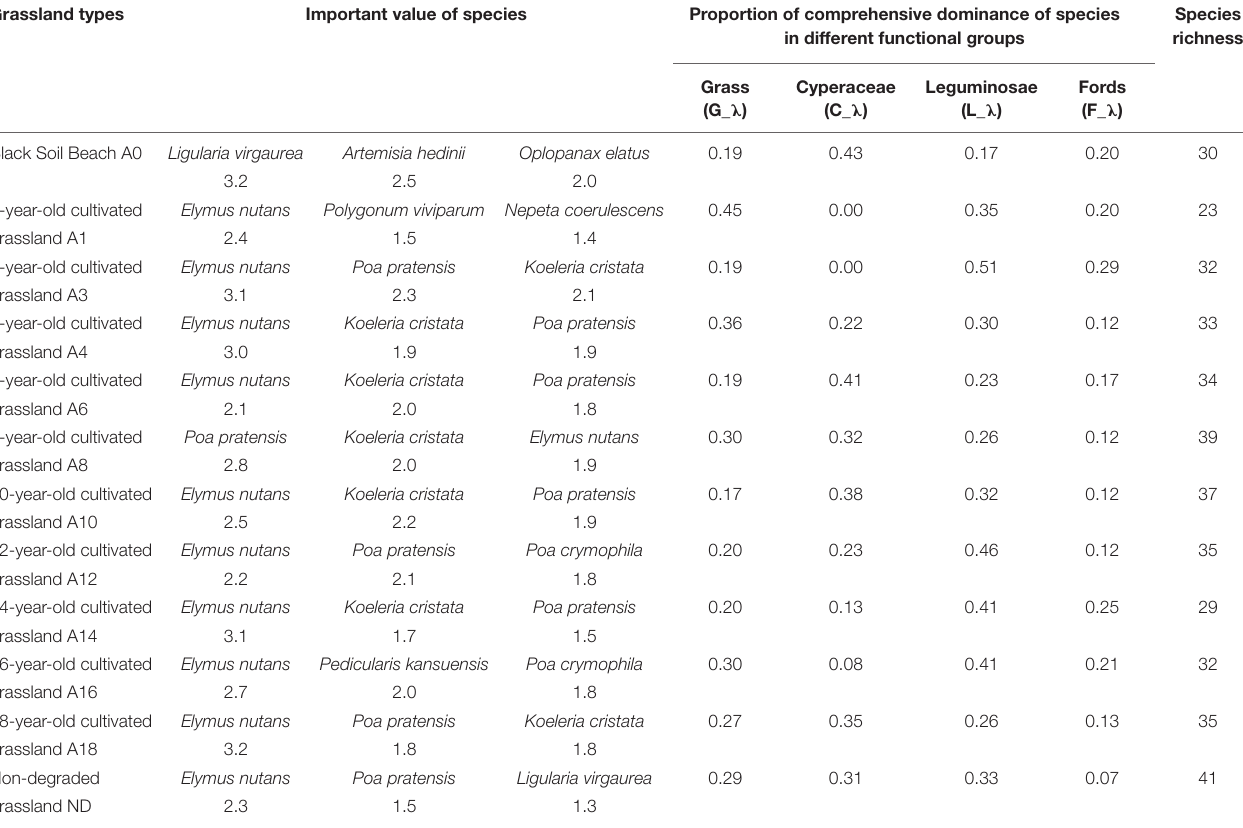
TABLE 1 | Important species of the plot and their important values and proportion of comprehensive dominance of species in different functional groups. Grassland types Important value of species Proportion of comprehensive dominance of species